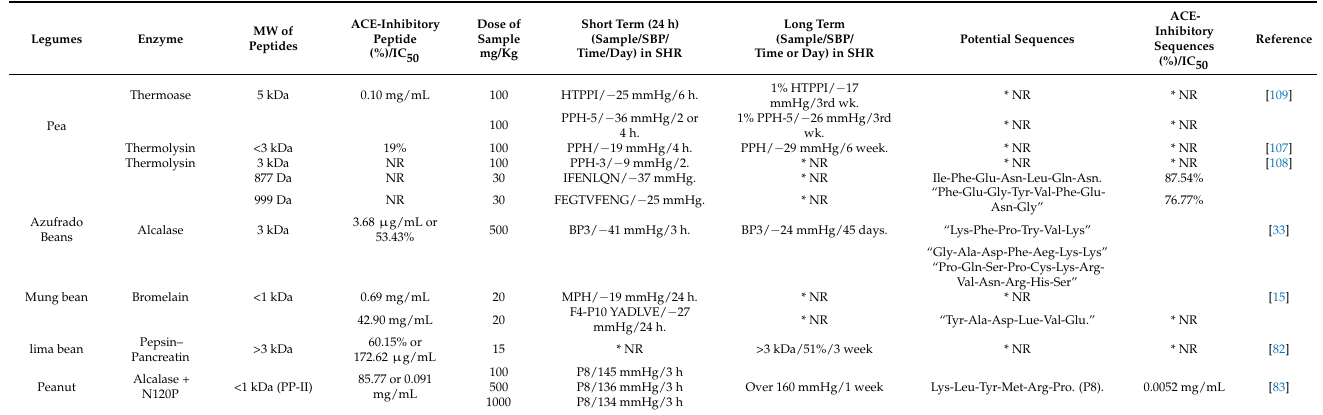
Table 3. In vivo: Effect of ACE peptide of legume protein hydrolysates in spontaneously hypertensive rats (HSRs) as short- and